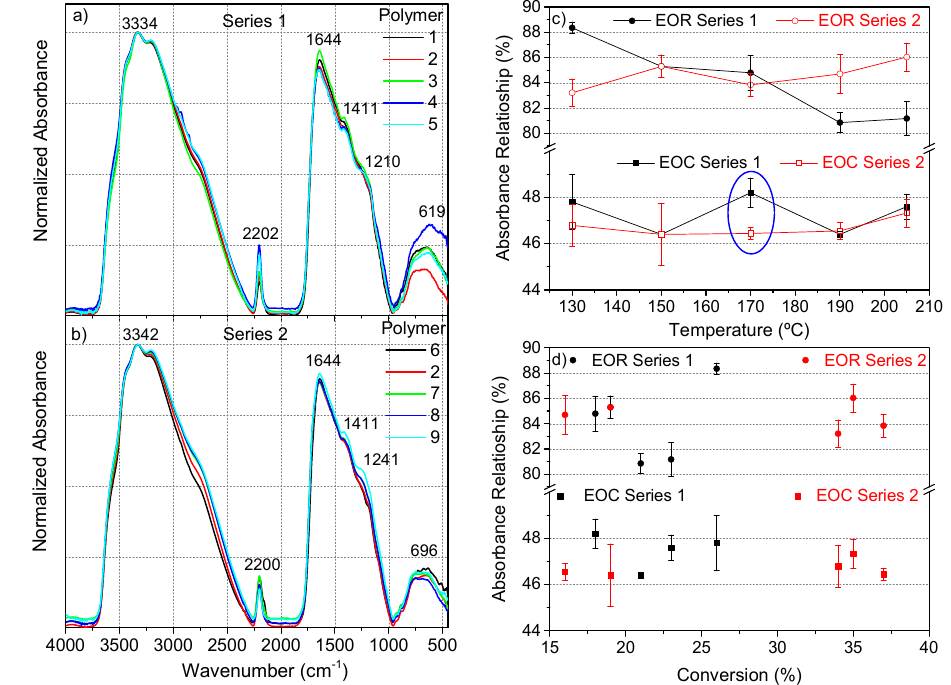
Figure 3. ( a ) Representative FTIR spectra of polymers 1 - 5 (series 1), and ( b ) of polymers 2 , 6 - 9 (series 2); ( c ) relationship of the EOR (extension of the reaction) and the EOC (extension of the conjugation) with the temperature; ( d ) dependence of both the EOR and EOC relationships on the conversion degree. ( c , d ) Each point was calculated from at least three FTIR spectra from independent samples.